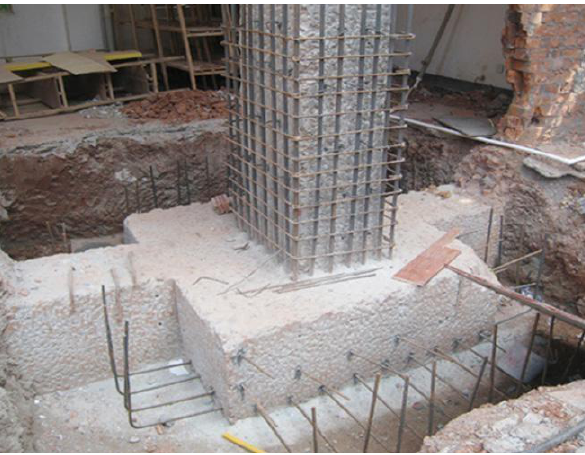
Figure 2. EPS applied in an actual structure.